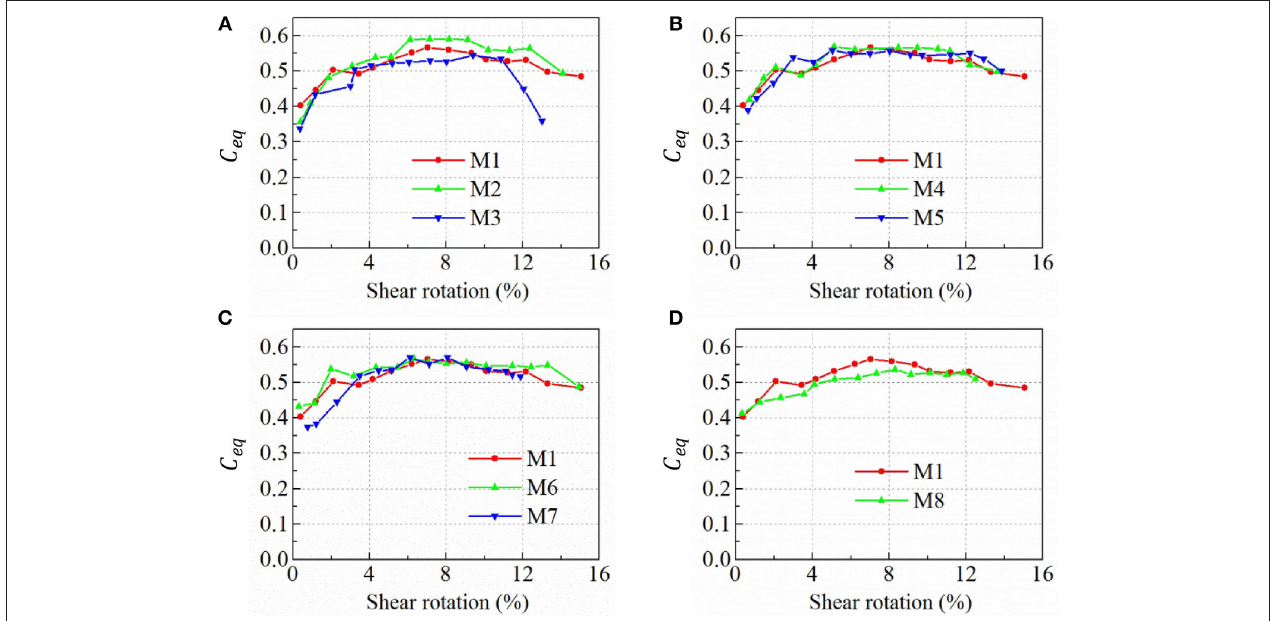
FIGURE 7 | Equivalent viscous damping coefficients of metallic dampers: (A) different web steel; (B) different specimen length; (C) different web depth; (D) different